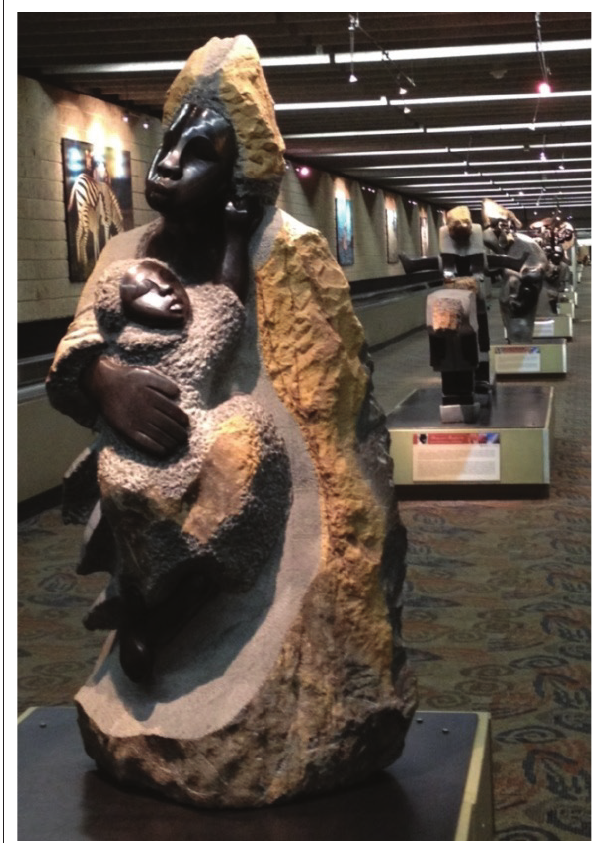
FIGURE 4: First lady stone, Agness